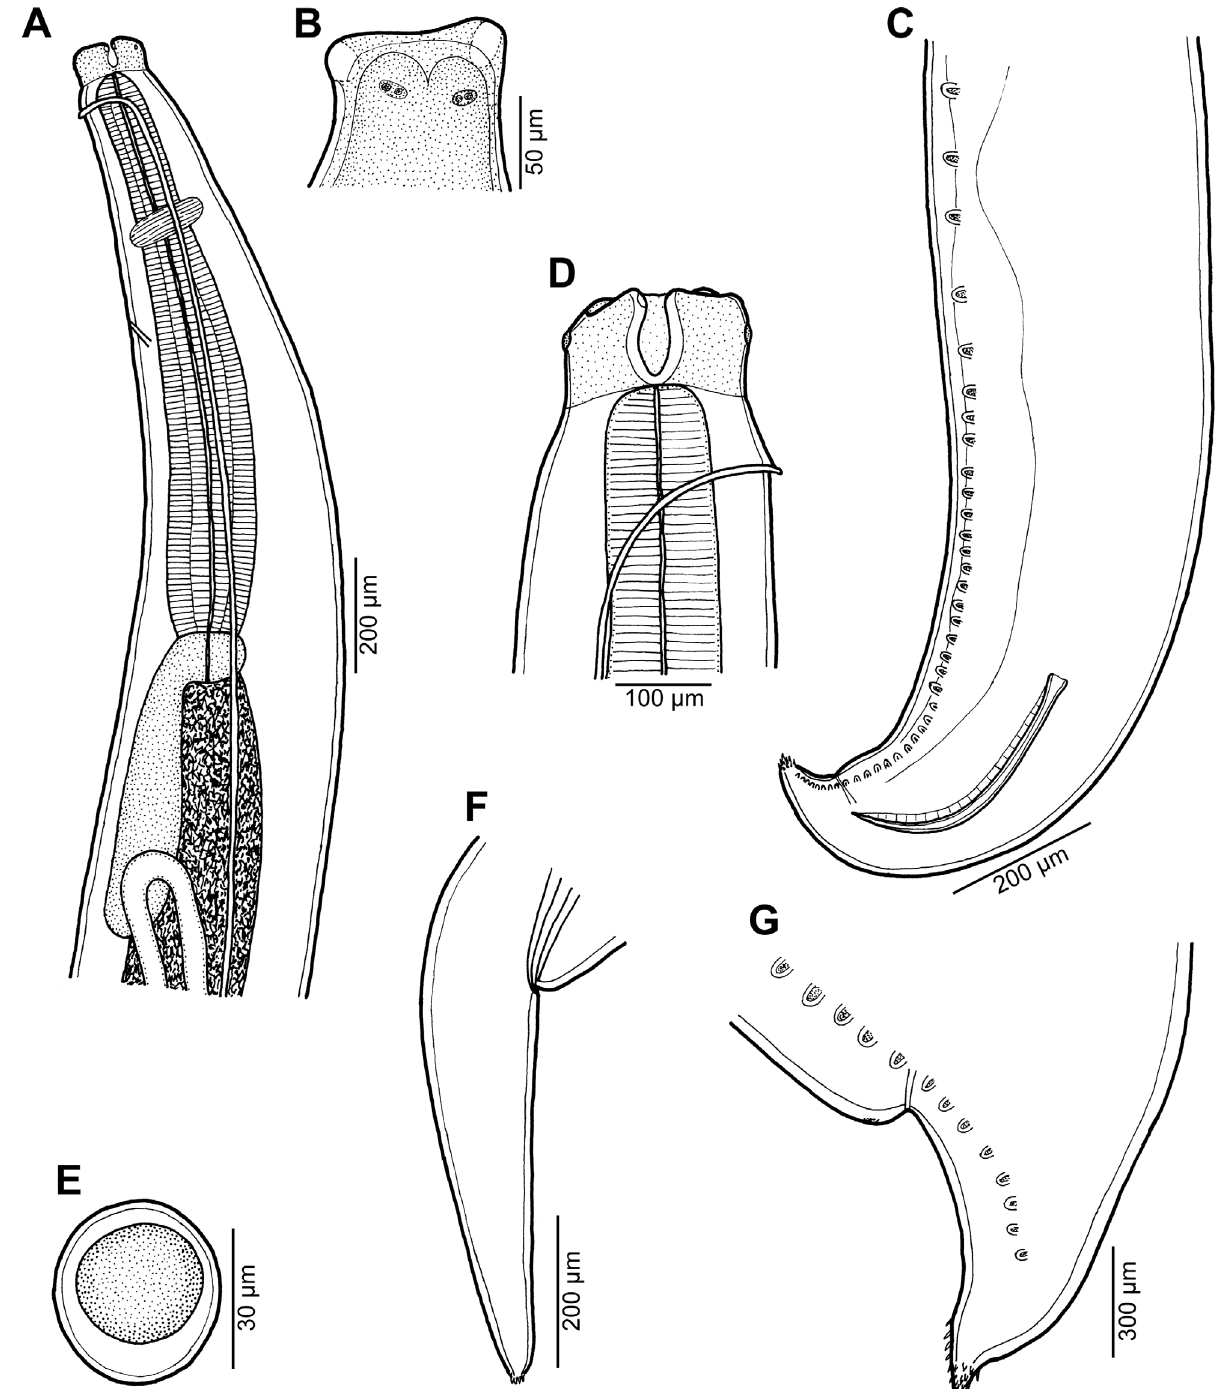
Figure 12. Raphidascaris ( Ichthyascaris ) elopsis n. sp. ex Elops hawaiensis . (A) Anterior end of male, lateral view; (B) dorsal lip; (C) posterior end of male, lateral view; (D) cephalic end of female, lateral view; (E) egg; (F) tail of female; (G) caudal end of male, lateral